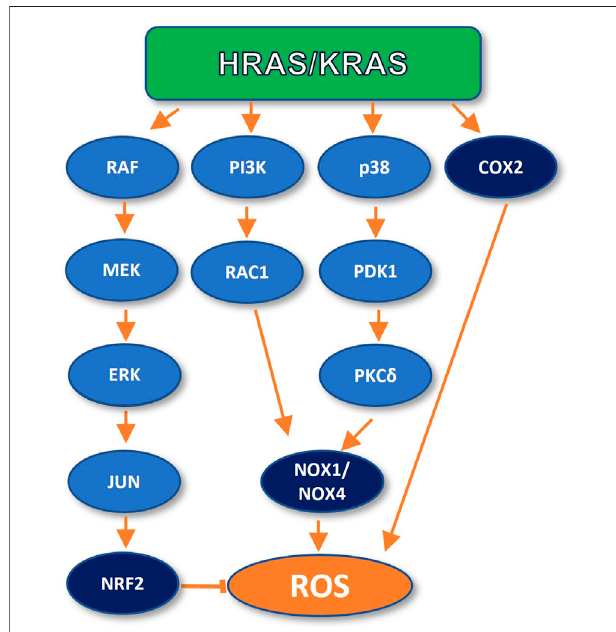
FIGURE1| OncogenicRAScaninhibitandpromoteROSgeneration.In early carcinogenesis, RAS inhibits ROS production by activating the NRF2 transcription factor. However, oncogenic RAS can also promote ROS generation through upregulation of NADPH oxidases (NOX1 and NOX4) and directly by COX2